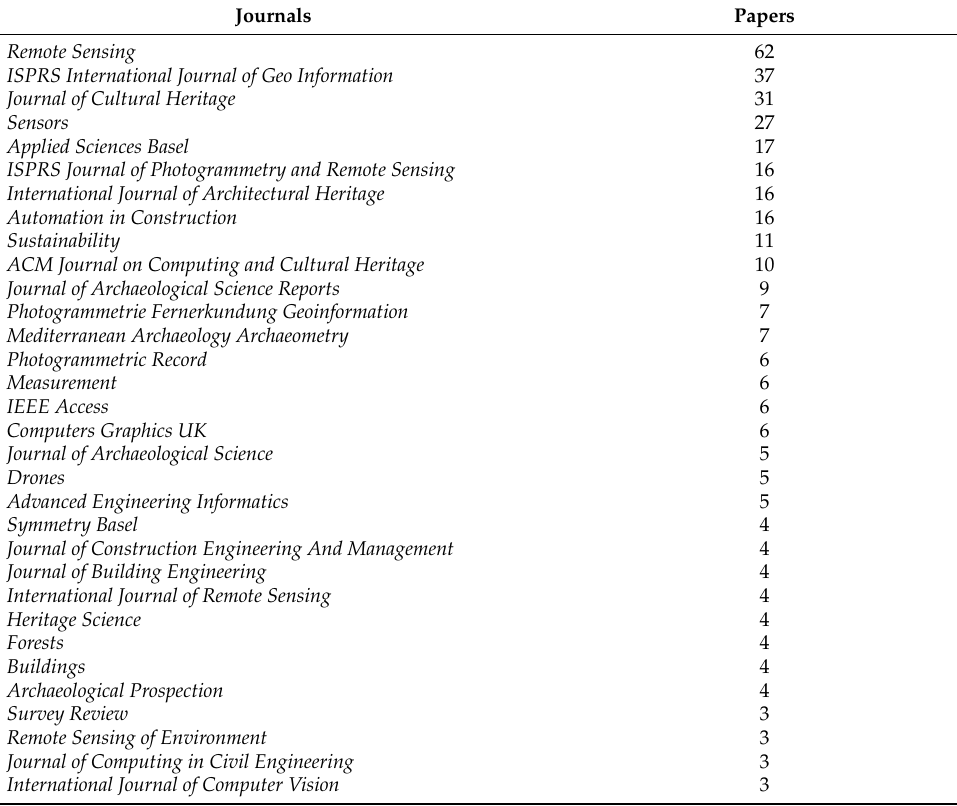
Table 1. Selected journals and the number of relevant